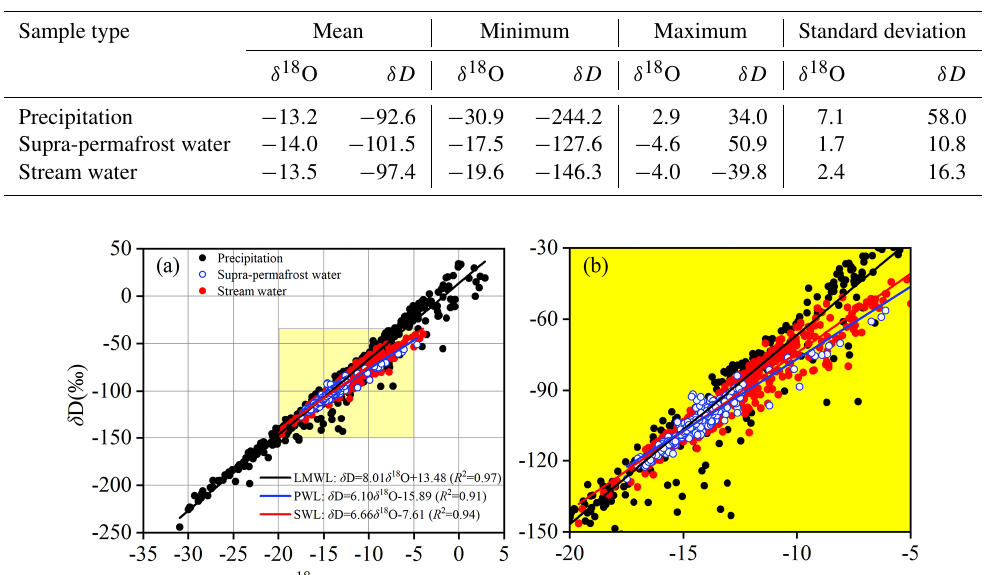
Table 3. Mean, range, and standard deviation of δ 18 O (‰) and δD (‰) for precipitation, stream water, and supra-permafrost water.